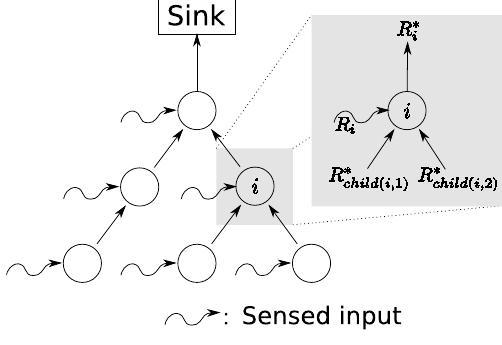
Figure 1. Sensor network